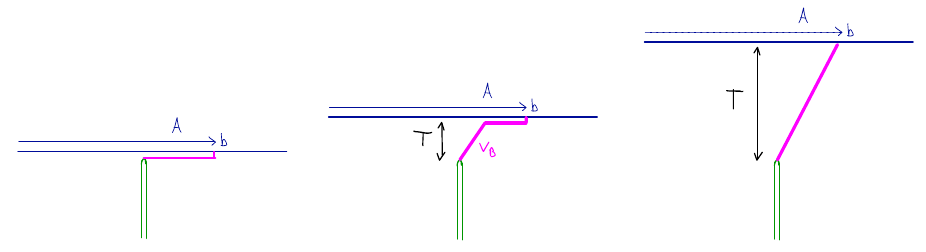
Figure 3 . The membrane theory description of the joining quench. The end of the world brane is the double half line from t = 0 to t = , and membranes can end on it anywhere. We included (cid:0)1 the membranes for the half space A ( T ) for T = 0, a time T < b=v B and T > b=v B . On the left (cid:12)gure the membrane is horizontal, and S ( T = 0) = s . On the middle (cid:12)gure the membrane th A (cid:6) b is composed of a horizontal piece and a \light sheet" of slope v B . On the right (cid:12)gure the minimal membrane is a sheet of slope b=T